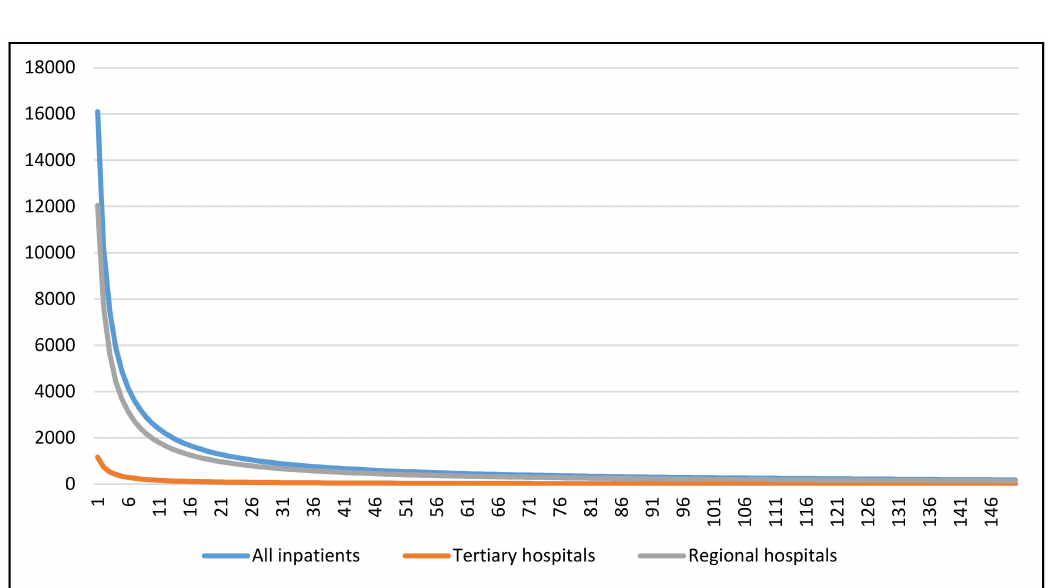
Figure 1. Inpatient distribution pattern among tertiary hospitals and regional hospitals captured by the fitted log-logistic function